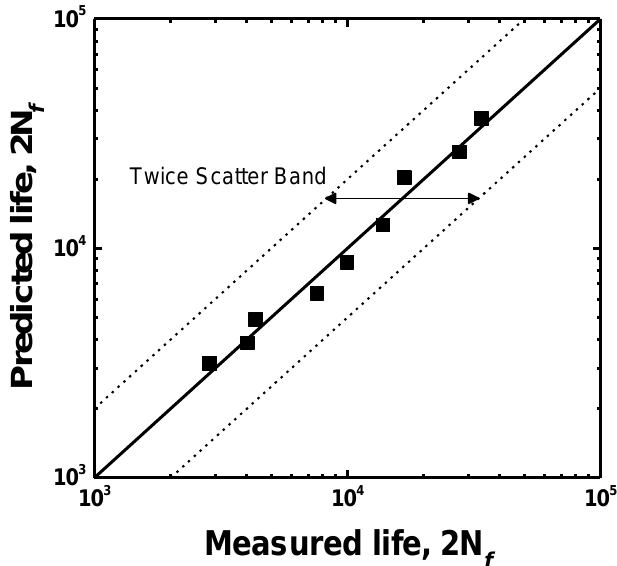
Figure 9. Comparison between the experimental and the predicted LCF life.